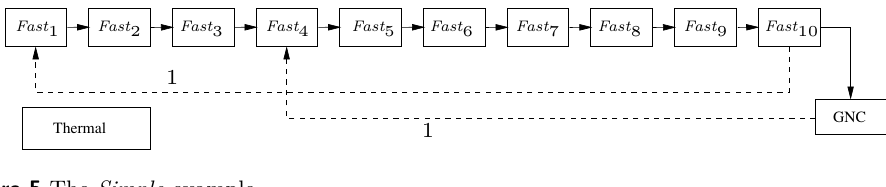
Figure 5 The Simple